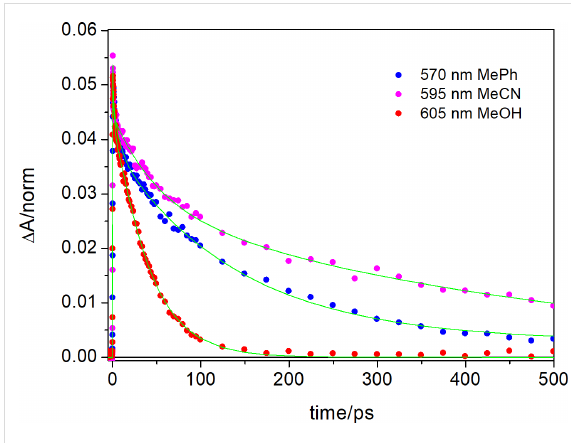
Figure 6: Kinetic traces recorded at the maximum of the excited state absorption band in toluene, acetonitrile and methanol. Two-photon